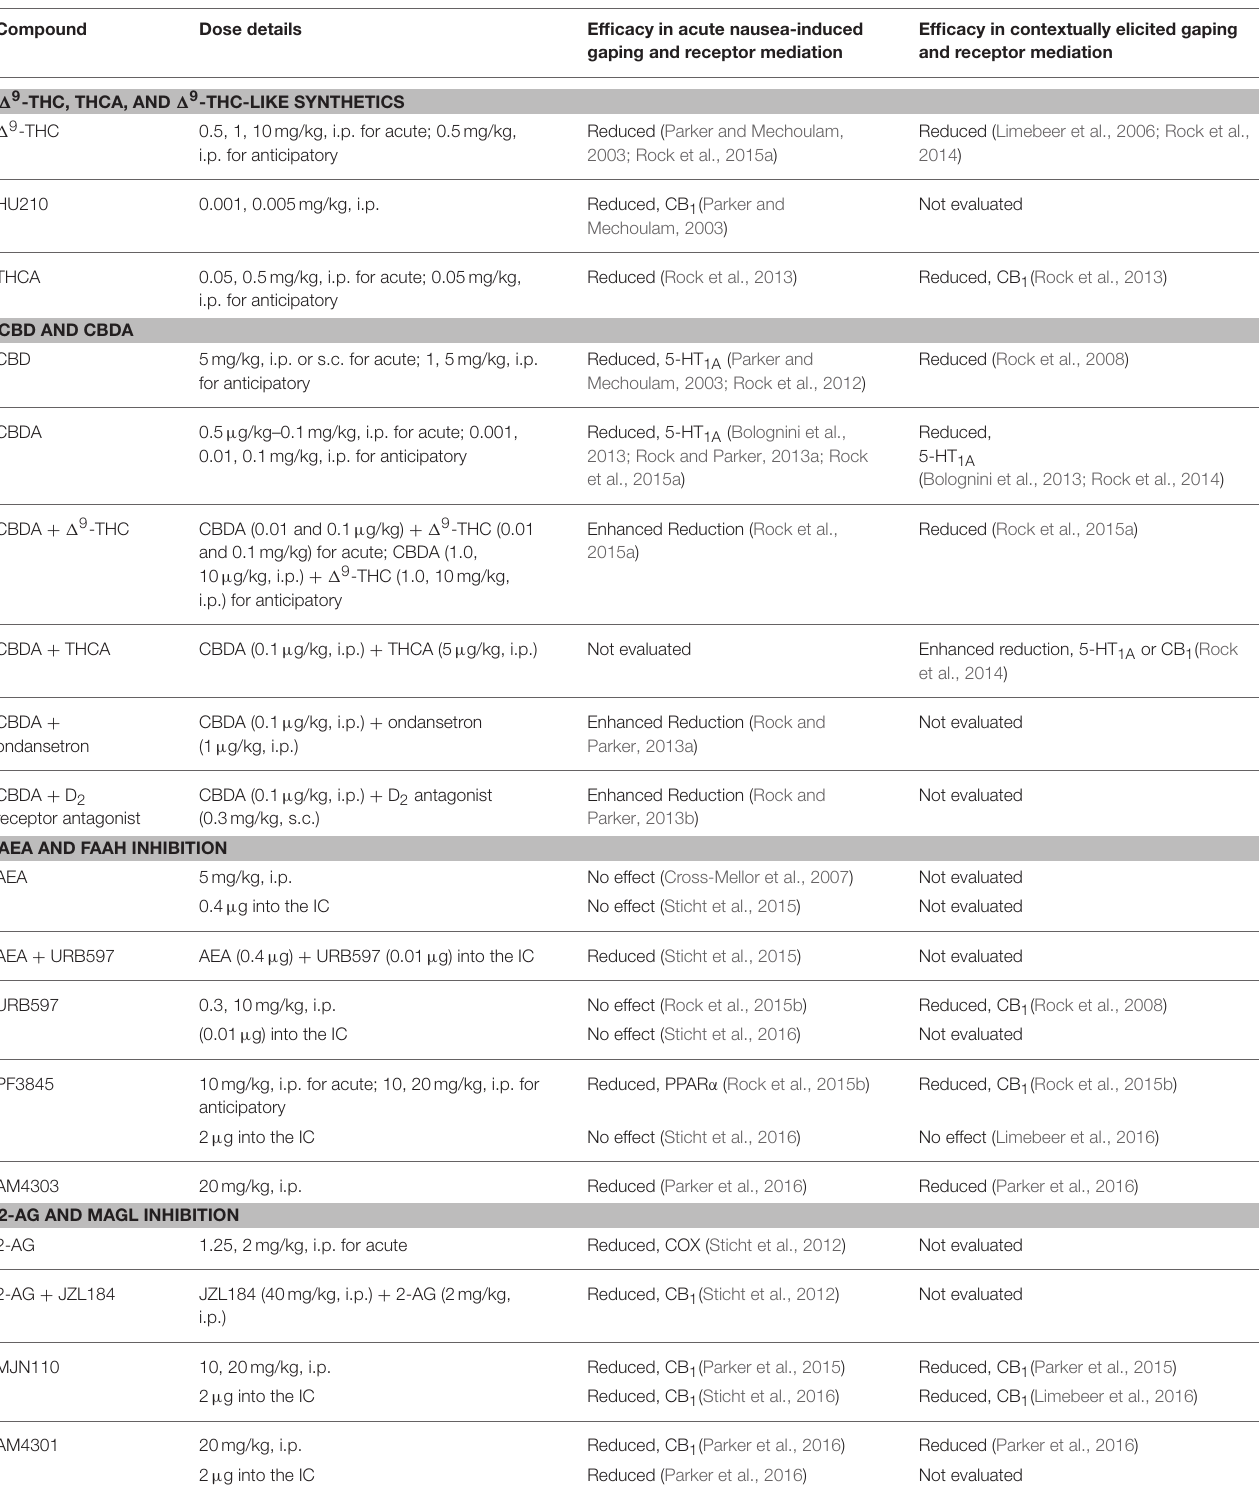
TABLE 2 | Effect of exogenous cannabinoids and manipulations of the endogenous cannabinoid system on models of acute and anticipatory nausea in rats. Compound Dose details Efficacy in acute nausea-induced